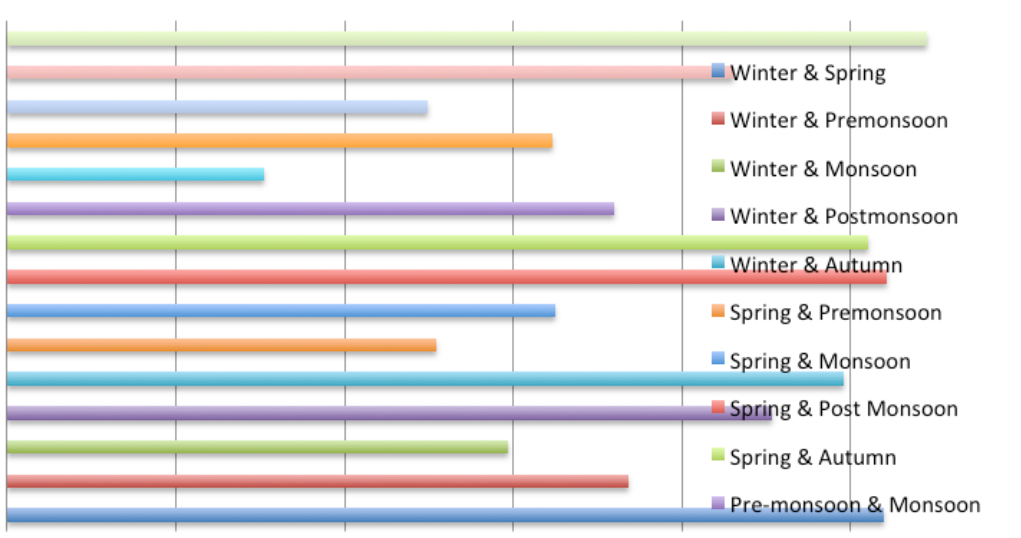
Figure 5. Butterfly species similarity between different seasons in Gibbon WS (August 2010–March